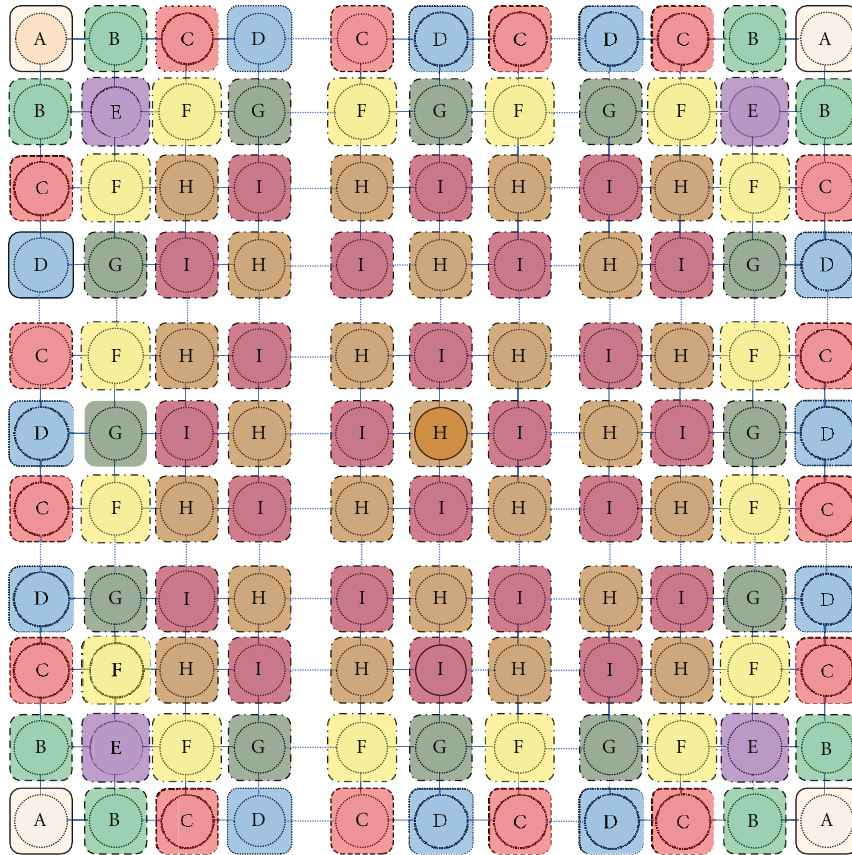
Figure 7: Di ff erent cases used for hando ff latency analysis in